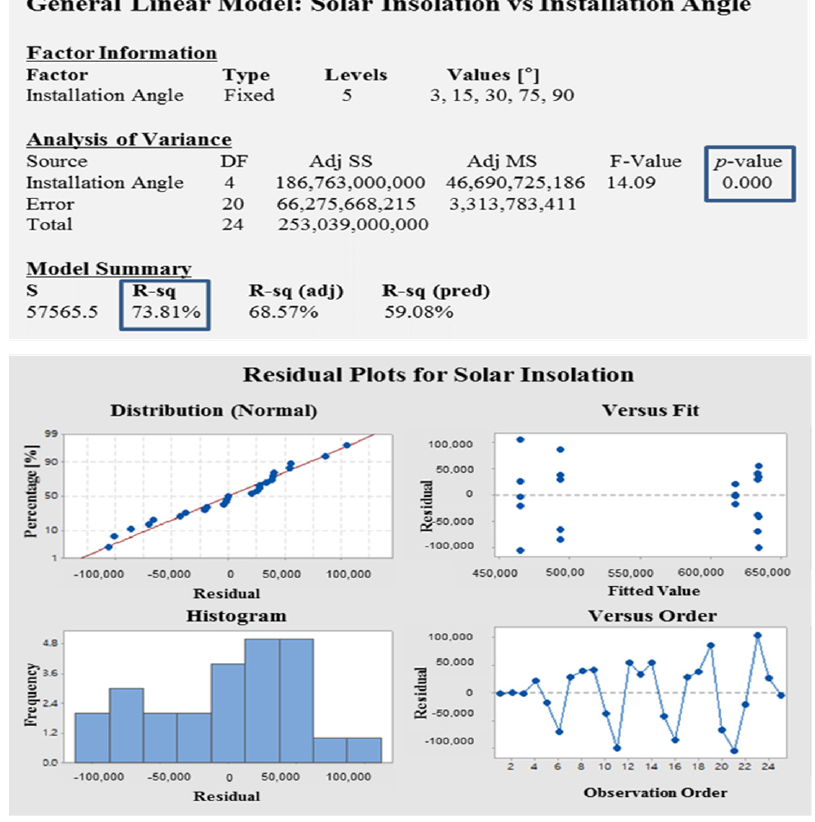
ff erent installation